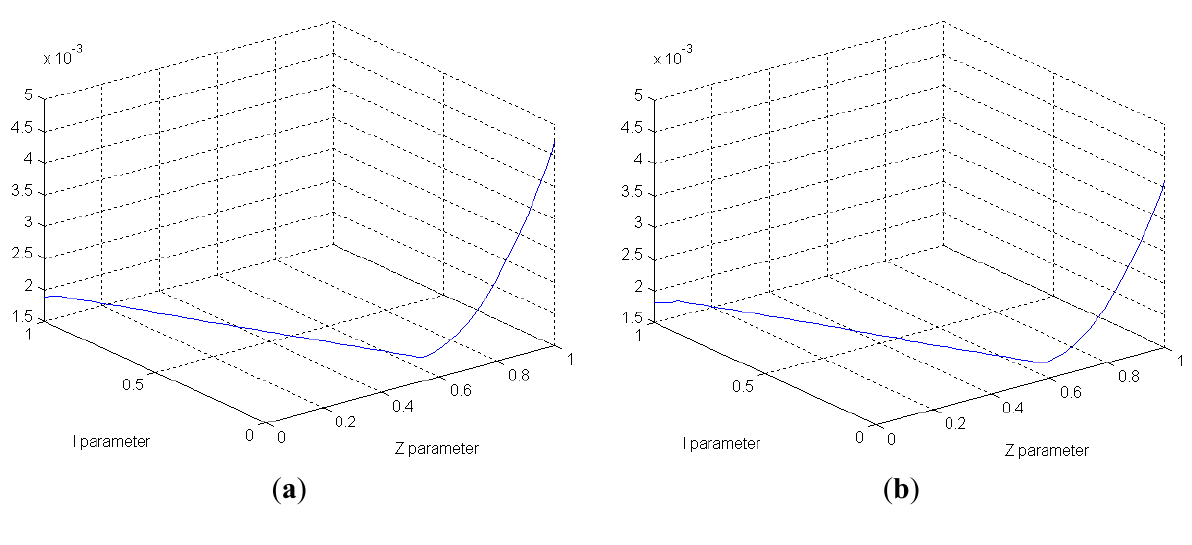
; ( b ) minimum reactive objective Z . Z